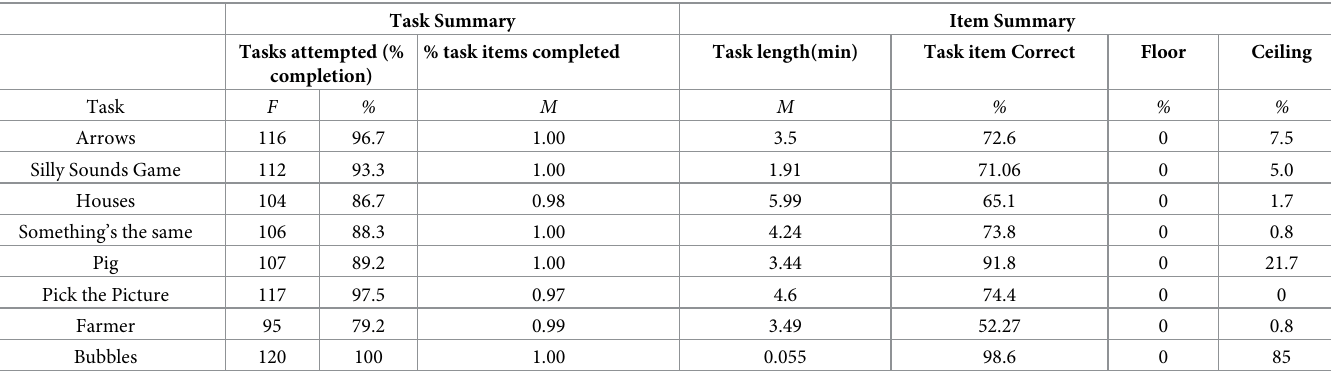
Table 1. Frequency and percentage of Executive function task metrics (N =